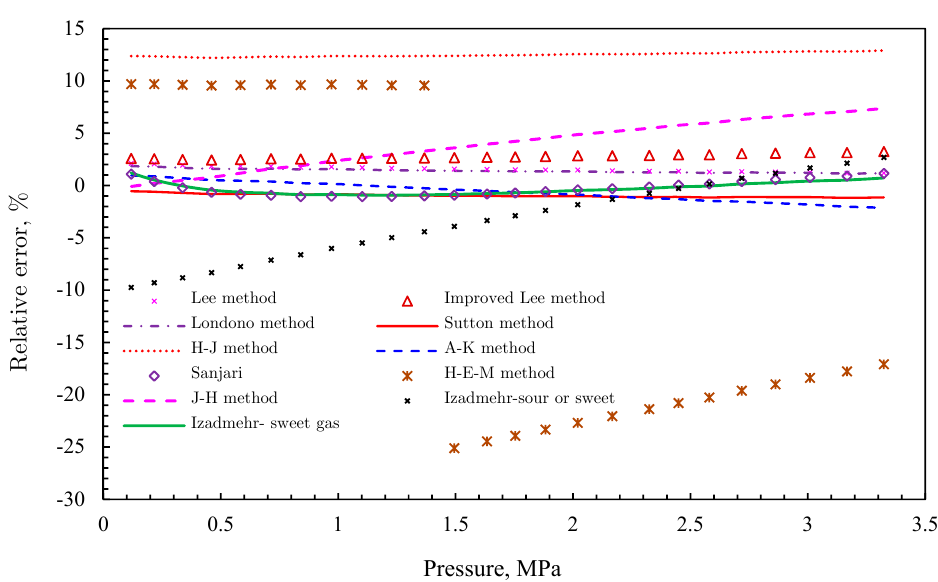
Figure 29. Model comparison for gas viscosity calculations as well as compared with experimental data at 293.15 K.